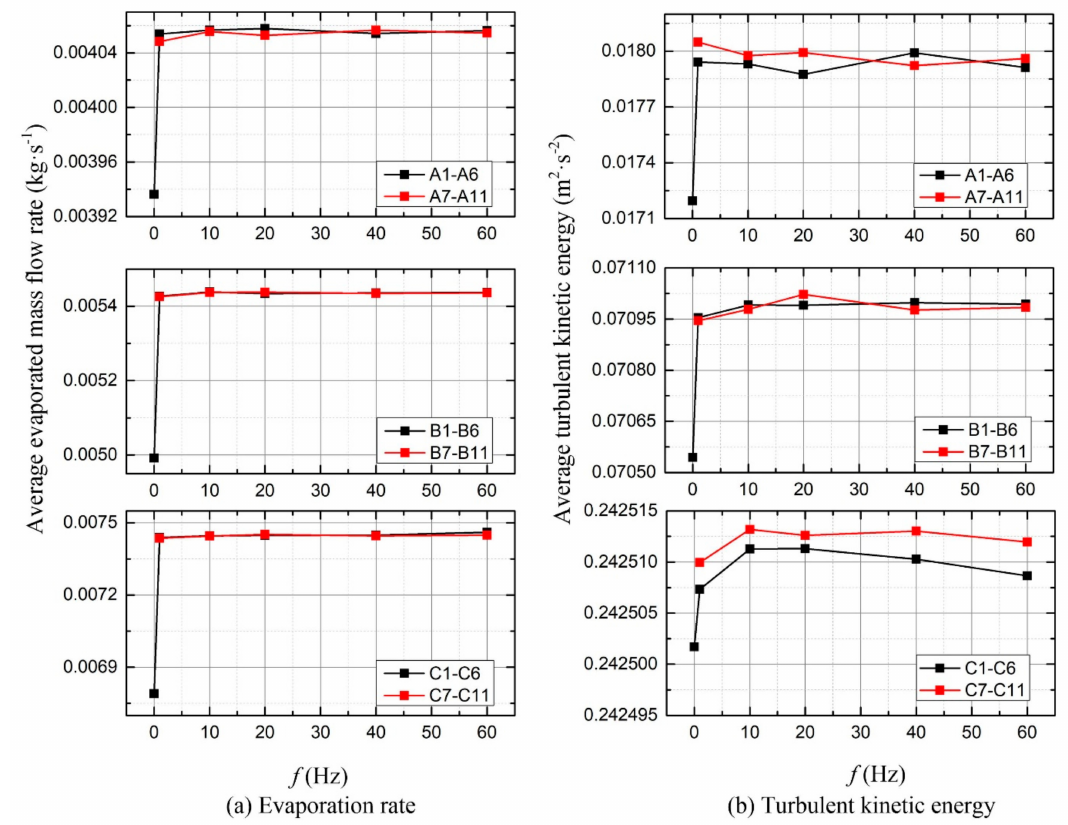
Figure 8. Average evaporation rate and turbulent kinetic energy under di ff erent